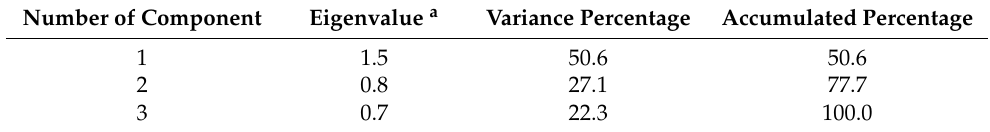
Table 2. Principal component analysis.